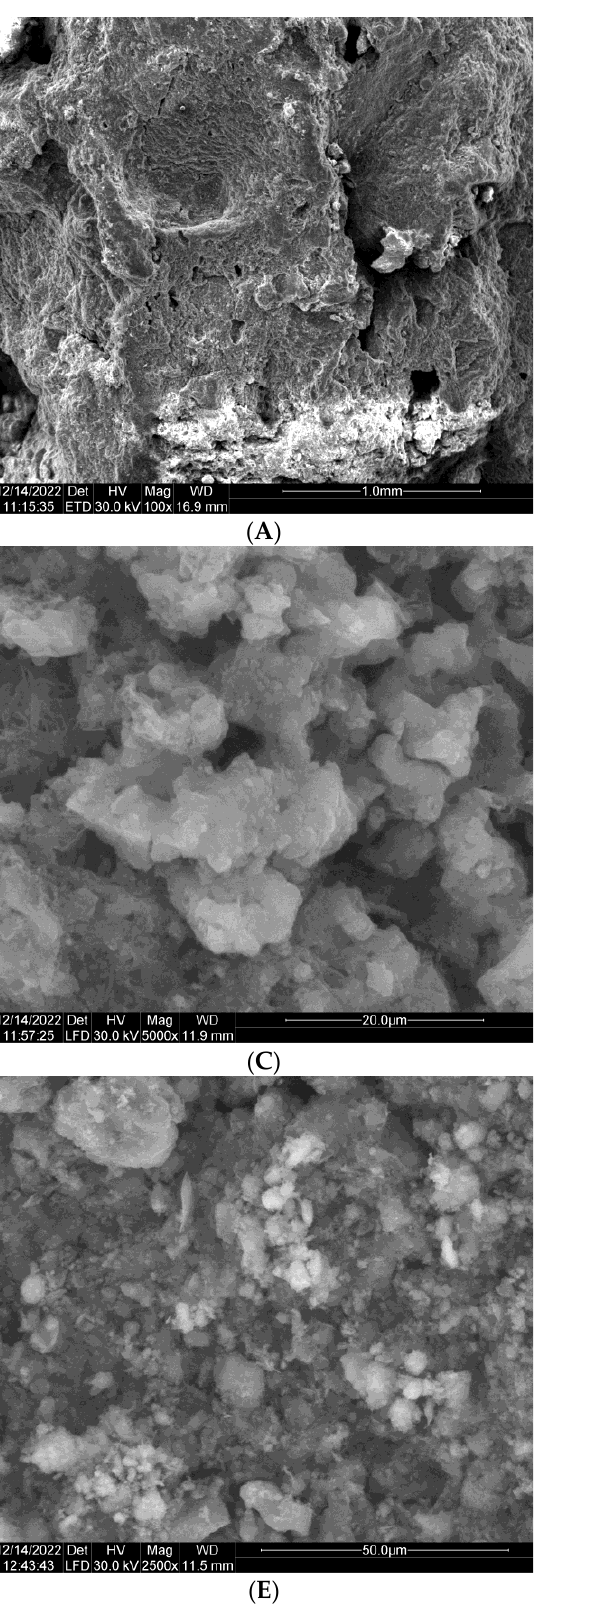
Figure 4. SEM images of the pottery, red area ( A , B ) and white area ( C – F ).